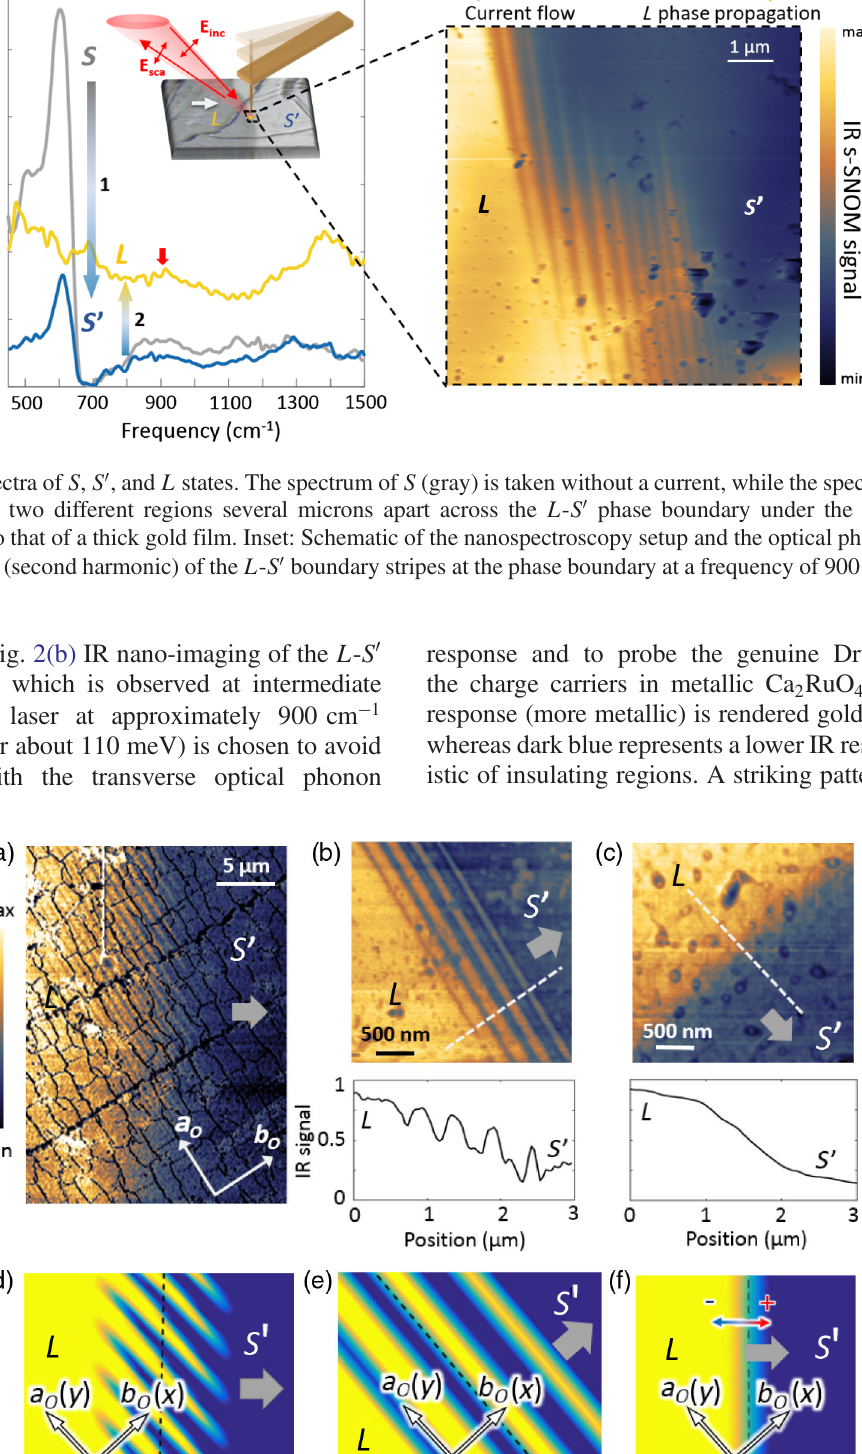
direction [27]. Yellow o